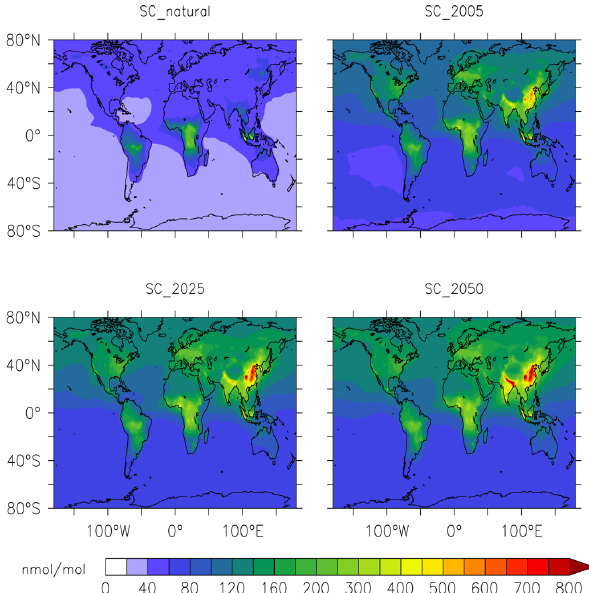
Fig. 6. Model calculated annual mean near-surface carbon monox- ide in nmol mol − 1 from simulation SC natural , SC 2005 , SC 2025 and SC 2050